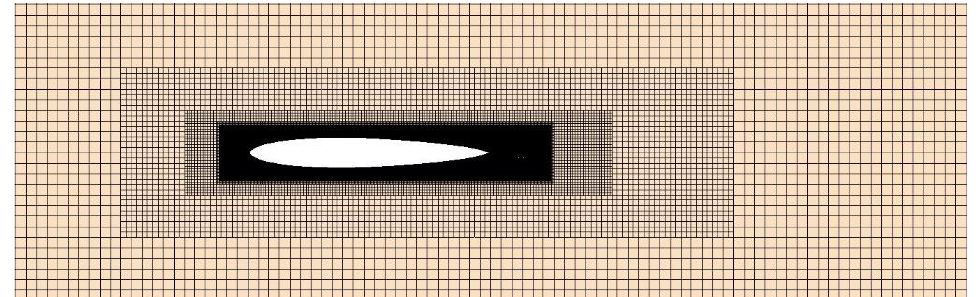
Figure 3. Mesh generation of the longitudinal section.